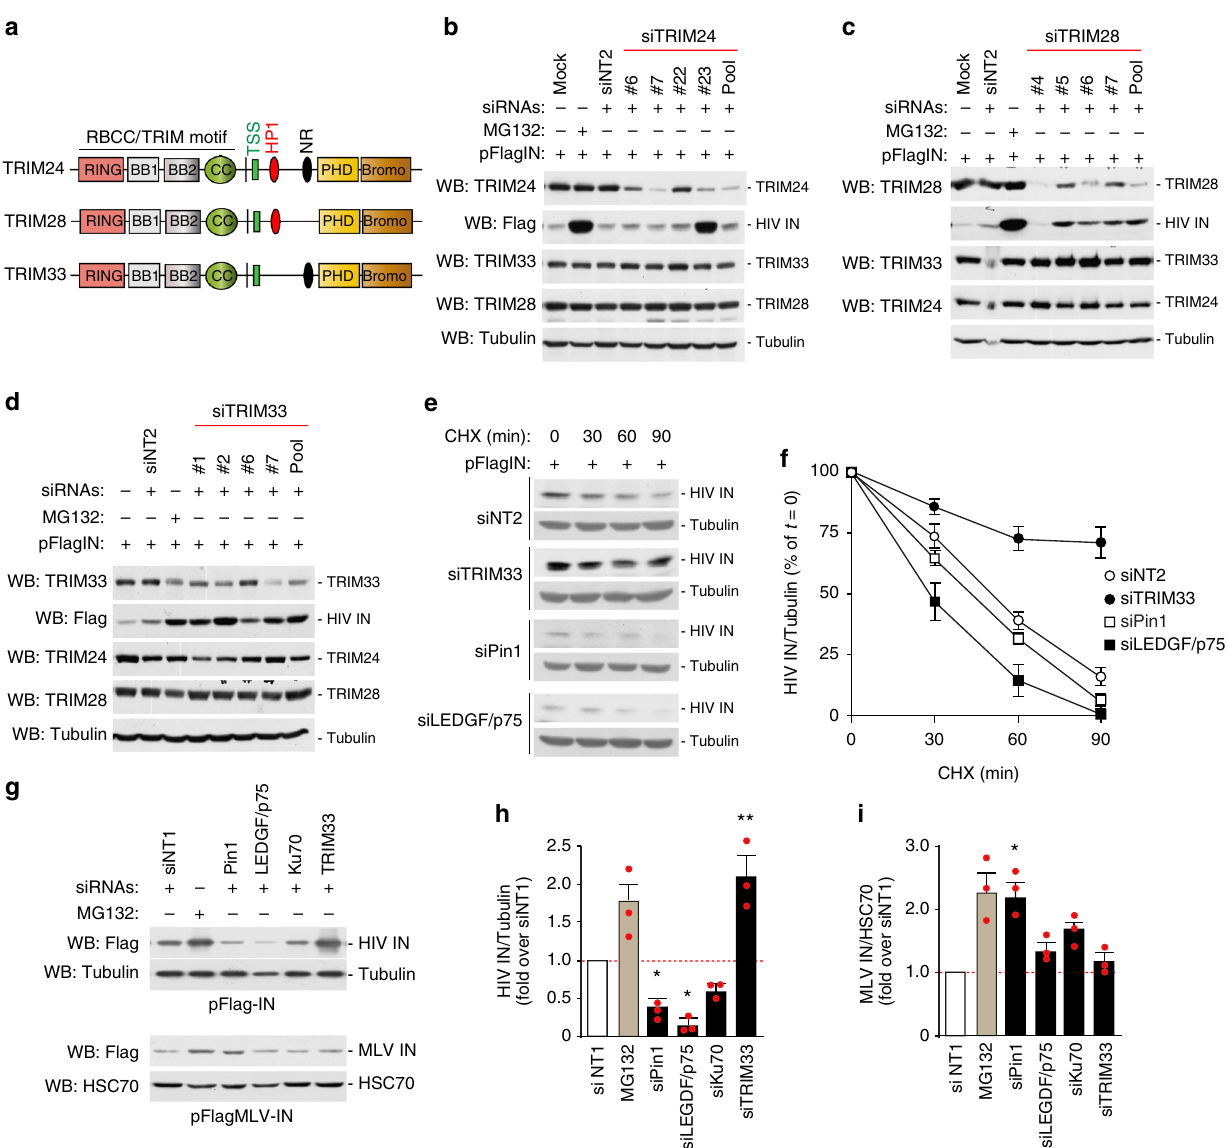
Fig. 3 Cellular TRIM33 is only TIF1 family member that negatively regulates HIV-1 integrase stability. a Schematic representation of domain organization of TIF1 subfamily members. b Effect of anti-TRIM24 siRNAs. The immunoblots show the levels of TRIM24, TRIM33, TRIM28, and HIV-1 IN in HeLa cells transfected with individual siRNAs against TRIM24 (#4, #5, #6, and #7), their pool (Pool) or non-targeting siRNA-2 (siNT2). MG132 was used to assess the effect of inhibiting proteasome-mediated protein degradation. c Effect of anti-TRIM28 siRNAs. Same as in panel b using siRNAs against TRIM28. d Effect of anti-TRIM33 siRNAs. Same as in panel b using siRNAs against TRIM33. e Stability of HIV-1 IN protein in siRNA-treated cells. Representative immunoblots showing the levels of HIV-1 IN after HeLa cell transfection with siRNAs against TRIM33, Pin1, and LEGF/p75 at different times and treatment with cycloheximide (30 µ g/ml) to block protein degradation. Tubulin served as a loading control. f Quanti fi cation of HIV-1 IN levels. Experiments were performed as in panel e . IN amounts are normalized to Tubulin and expressed as percent over IN at time = 0 for each treatment. Data are mean ± SEM; n = 3 independent experiments. g Effects of siRNAs on the levels of HIV-1 and MLV IN proteins. The fi gure shows representative immunoblots using lysates of HeLa cells transfected to express either Flag-IN from HIV-1 (upper part) or MLV-IN (lower part)and siRNAs against the indicated factors. Tubulin and HSC70 served as loading controls. h Quanti fi cation of the effects of siRNAs against the indicated factors or treatment with MG132 on the levels of HIV-1 IN. IN levels are expressed after normalization for tubulin and as fold over non-targeting siRNA siNT1. Data are mean ± SEM; n = 3 independent experiments; * P < 0.05; ** P < 0.01; one-way ANOVA. i Same as in panel g for MLV-IN. Normalization was for cellular HSC70. Data are mean ± SEM; n = 3 independent experiments; * P < 0.05; one-way